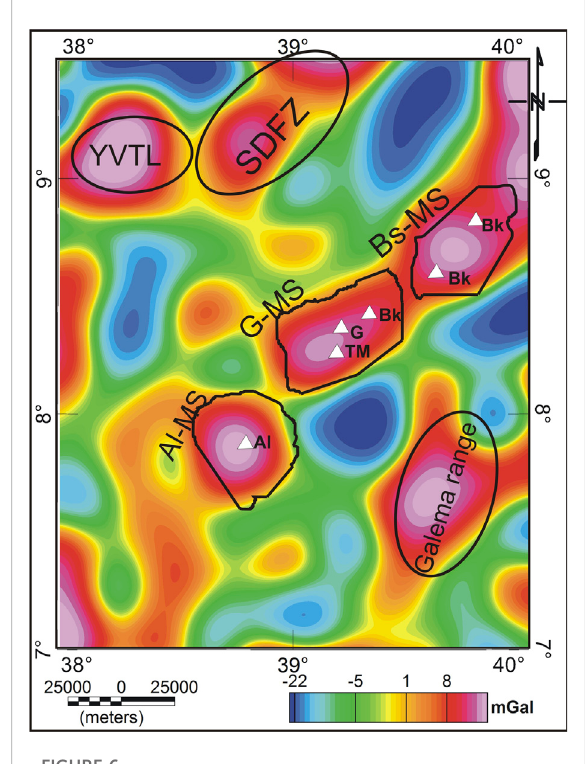
FIGURE 6 Bandpass fi ltered regional gravity anomaly map of the MER where wavelengths between 40 and 130 km are passed. The elliptical-shaped solid black lines are the off-rift volcanic regions (YVTZ, SDFZ, and Galema range). Labels: Al-MS, G-MS, and Bs-MS represent Aluto, Gedemsa, and Boseti magmatic segments